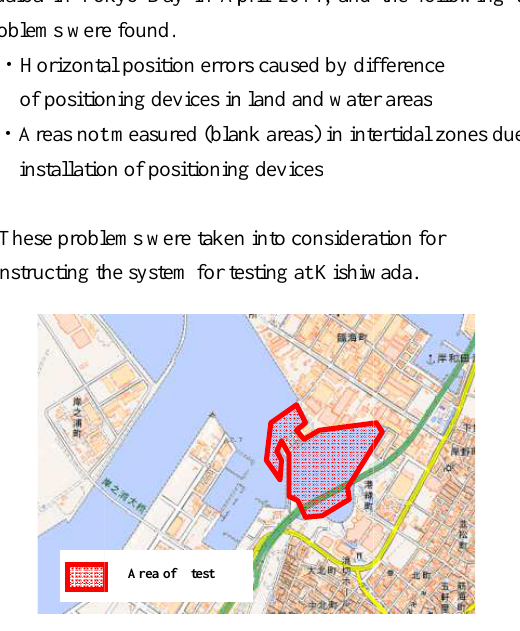
Figure. 3. Verification test site (Kishiwada Port in